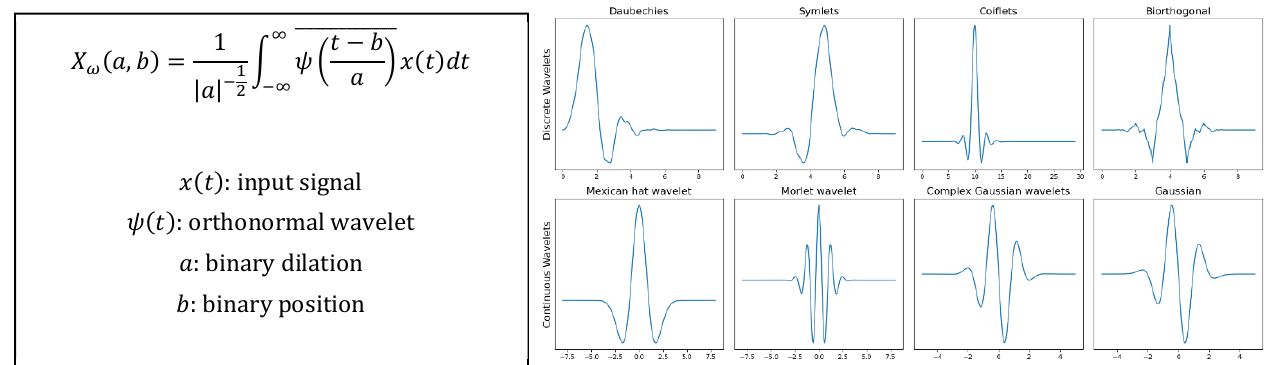
Figure 7. Wavelet transform equations and representation of different wavelets.